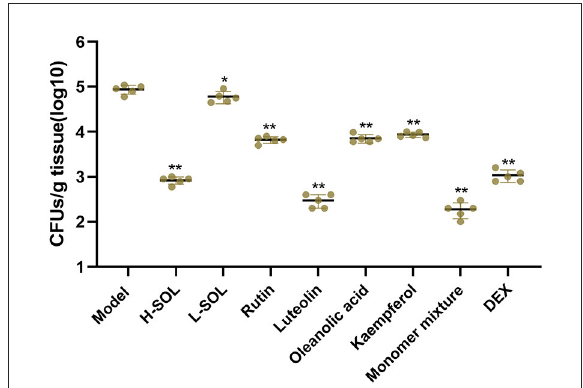
FIGURE7 Bacterial load in uterus tissues . The model mice served as control. Results are shown as means ± SD. Significantly different ( * p < 0.05 and ** p < 0.01) compared to the model group.